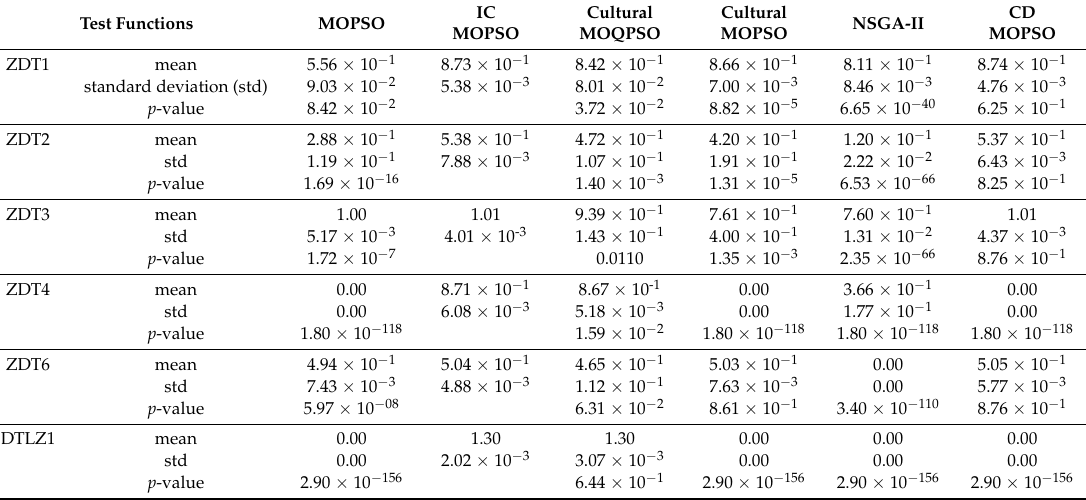
Table 1. Hypervolume values for 30 runs of the test